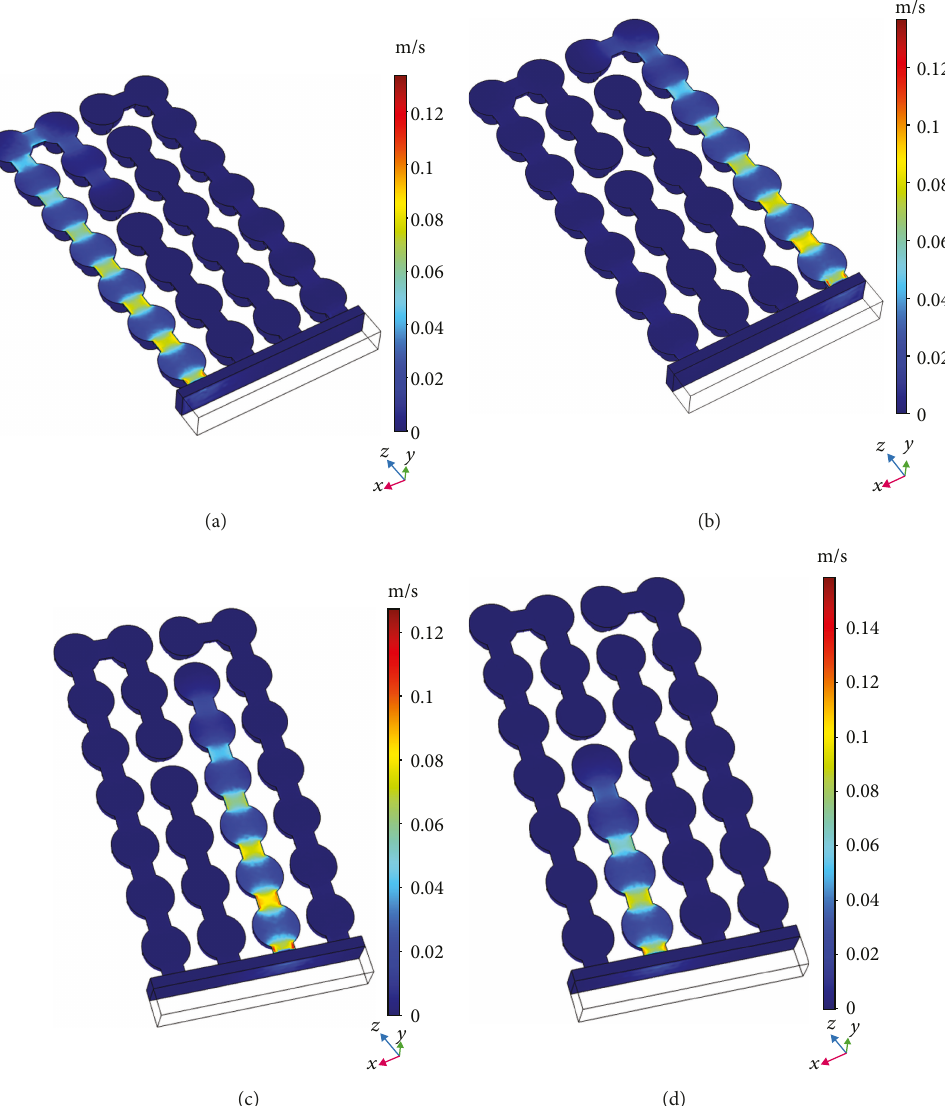
Figure 12: Axial component of velocity (m/s) within the lattice: (a) f = 1250Hz ; (b) f = 1550 Hz ; (c) f = 2050Hz ; (d) f = 3050Hz